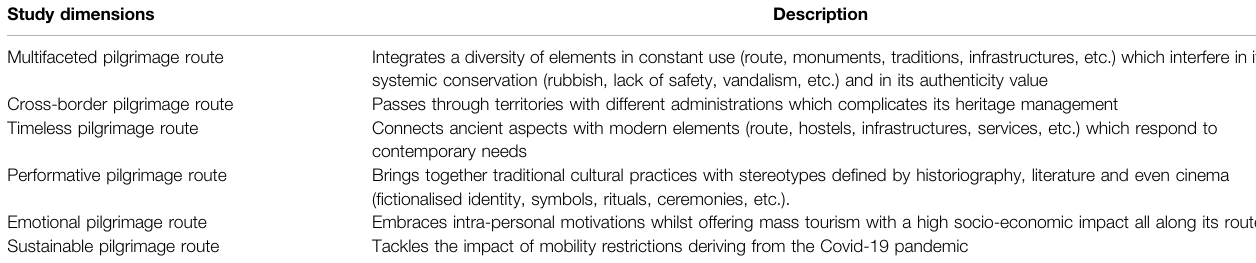
TABLE 1 | Study dimensions on the Way of St.